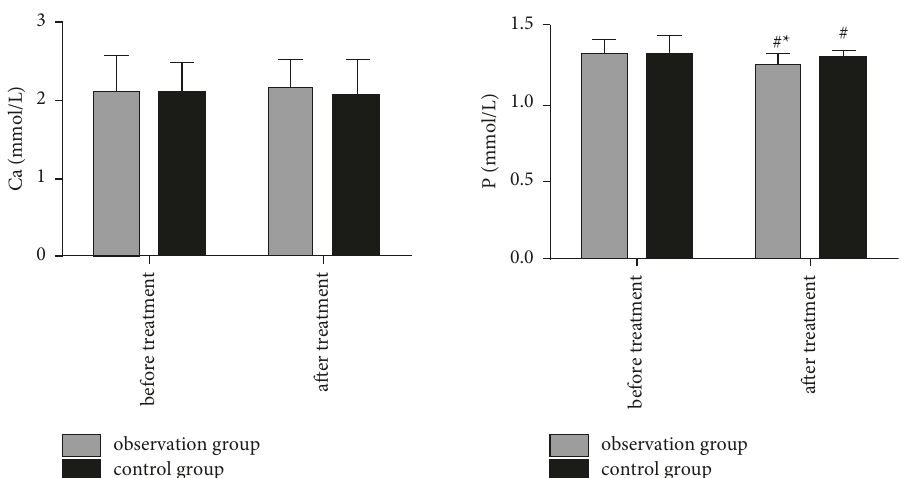
Figure 2: Comparison of calcium and phosphorus metabolism indexes between groups with/without prebiotics/probiotics preparations ( # P < 0 . 05 represents comparing with the same group before treatment; ∗ P < 0 . 05 represents comparing with the control